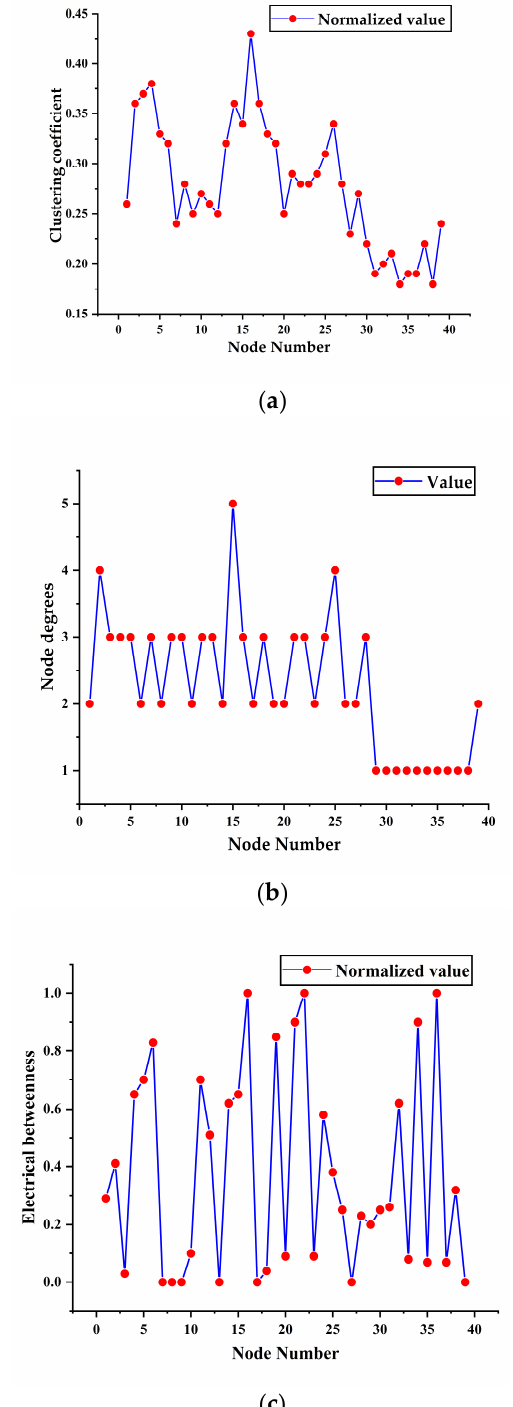
Figure 4. Distribution of indicators at nodes. ( a ) Distribution diagram of node degrees with electrical characteristics. ( b ) Distribution diagram of node aggregation coefficients with electrical characteristics. ( c ) Dielectric diagram with electrical characteristics .